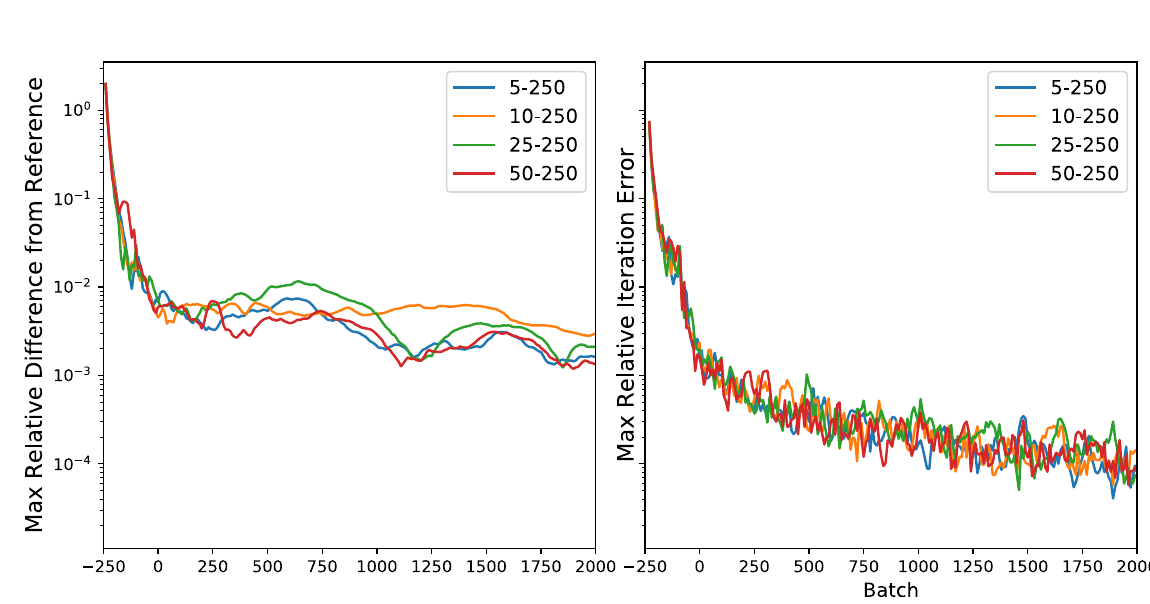
Figure 4: TF-XE (power): Maximum difference from reference and iteration error